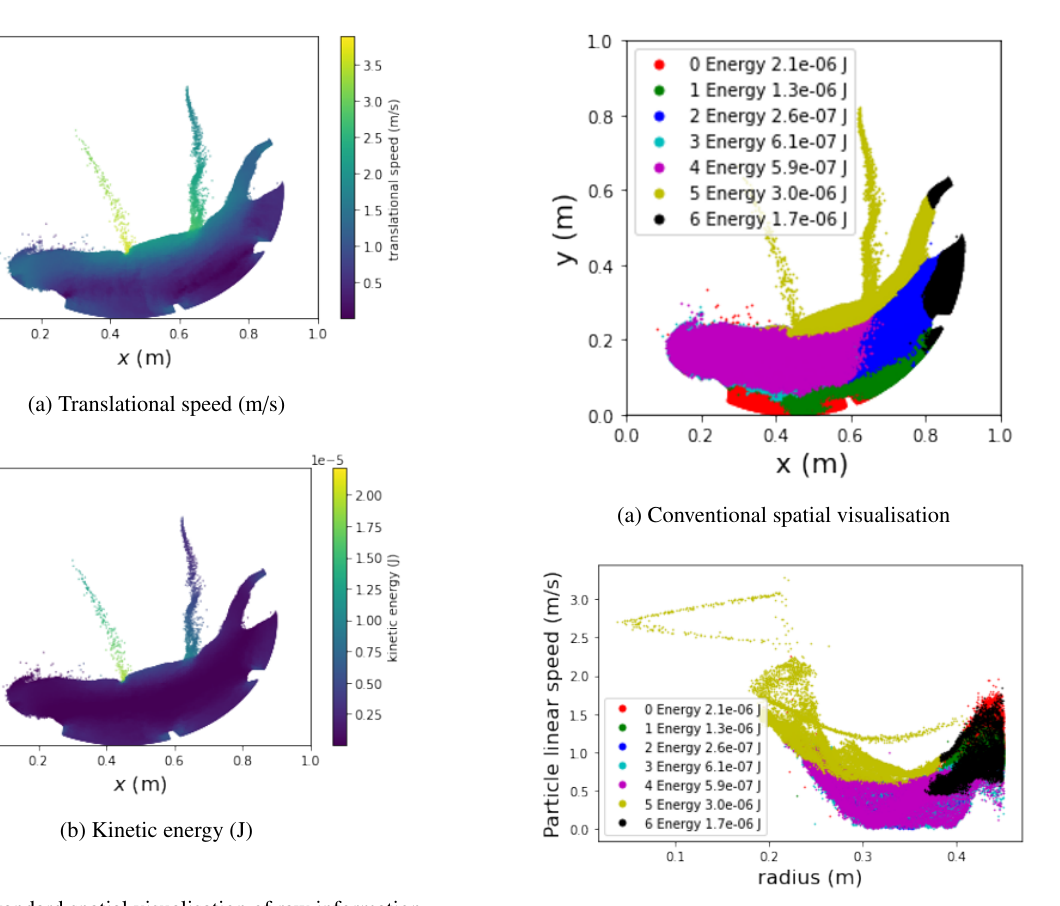
Figure 5: (a) Conventional spatial visualisation and (b) non- conventional phase-space visualisation of standard or corrobora- tive information. Total kinetic energy for each spatial domain is